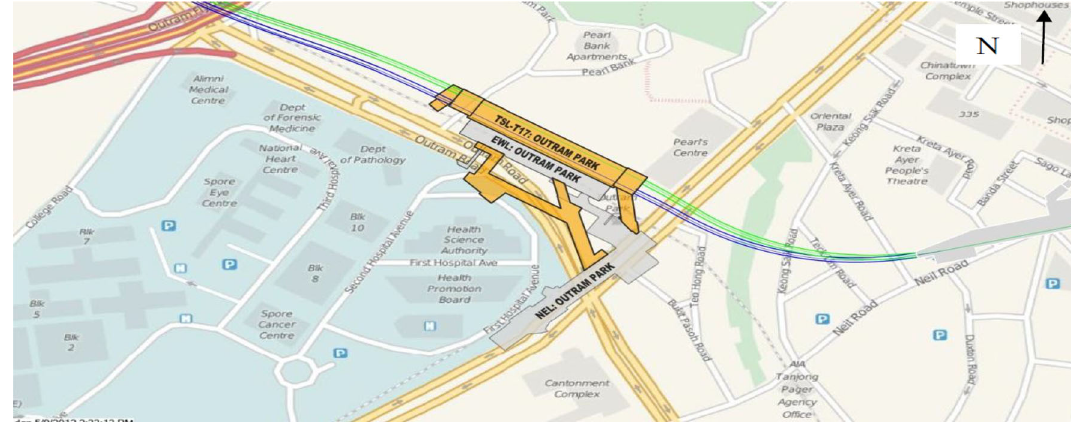
Fig. 1 Site plan of the project